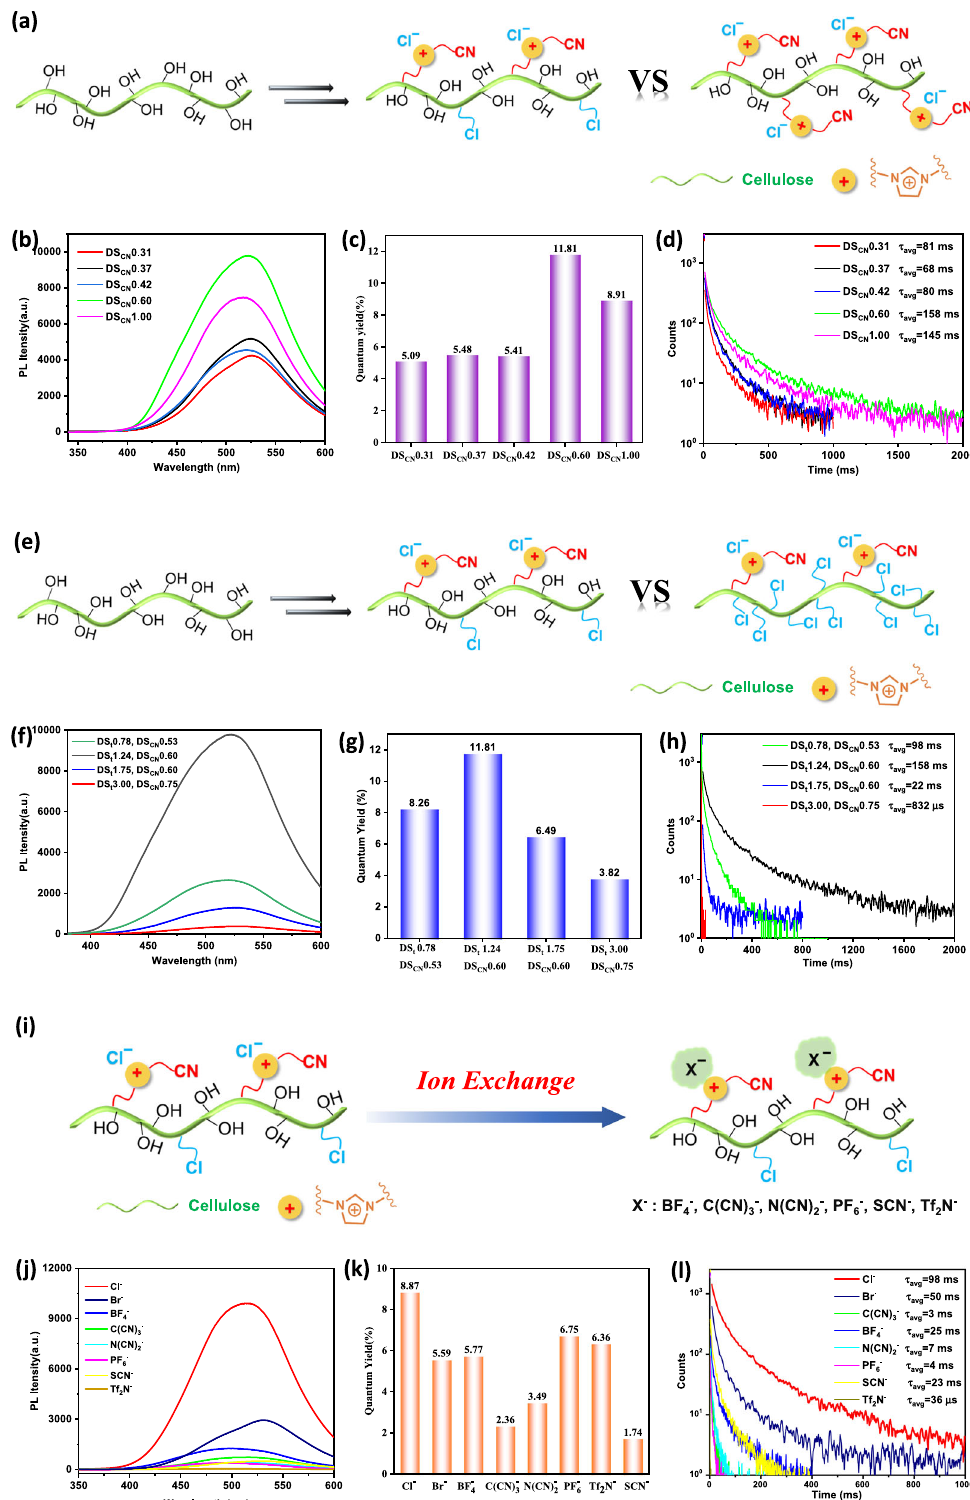
Fig. 3 In fl uence of the chemical structure of Cell-ImCNCl on its RTP performance. a Schematic diagram of Cell-ImCNCl with different DS CN ; b RTP spectra of Cell-ImCNCl with different DS CN (Ex = 320 nm); c Photoluminescence quantum yield of Cell-ImCNCl with different DS CN (Ex = 320 nm); d RTP lifetime spectra of Cell-ImCNCl with different DS CN ; e Schematic diagram of Cell-ImCNCl with different DS t ; f RTP spectra of Cell-ImCNCl with different DS t (Ex = 320 nm); g Photoluminescence quantum yield of Cell-ImCNCl with different DS t (Ex = 320 nm); h RTP lifetime spectra of Cell-ImCNCl with different DS t ; i Schematic diagram of Cell-ImCNX with different anions; j RTP spectra of Cell-ImCNX (Ex = 320 nm); k Photoluminescence quantum yield of Cell-ImCNX with different anions; l RTP lifetime spectra of Cell-ImCNX with different anions.